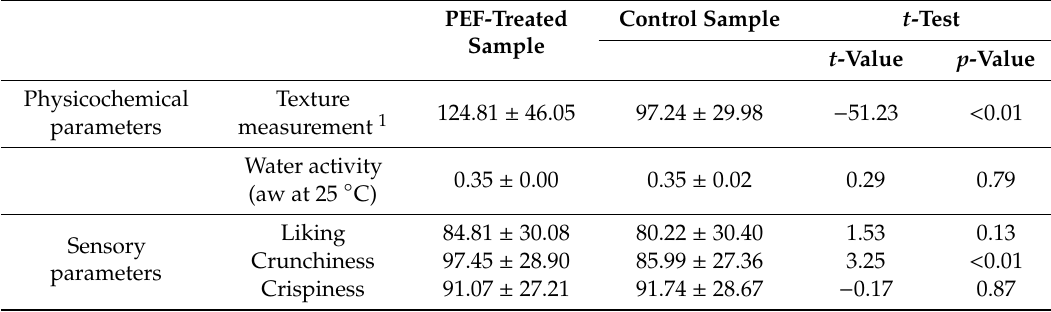
Table 2. Summary of means (and standard deviation) of the physicochemical and sensory parameters of the PEF-treated and control potato chips used in this study.